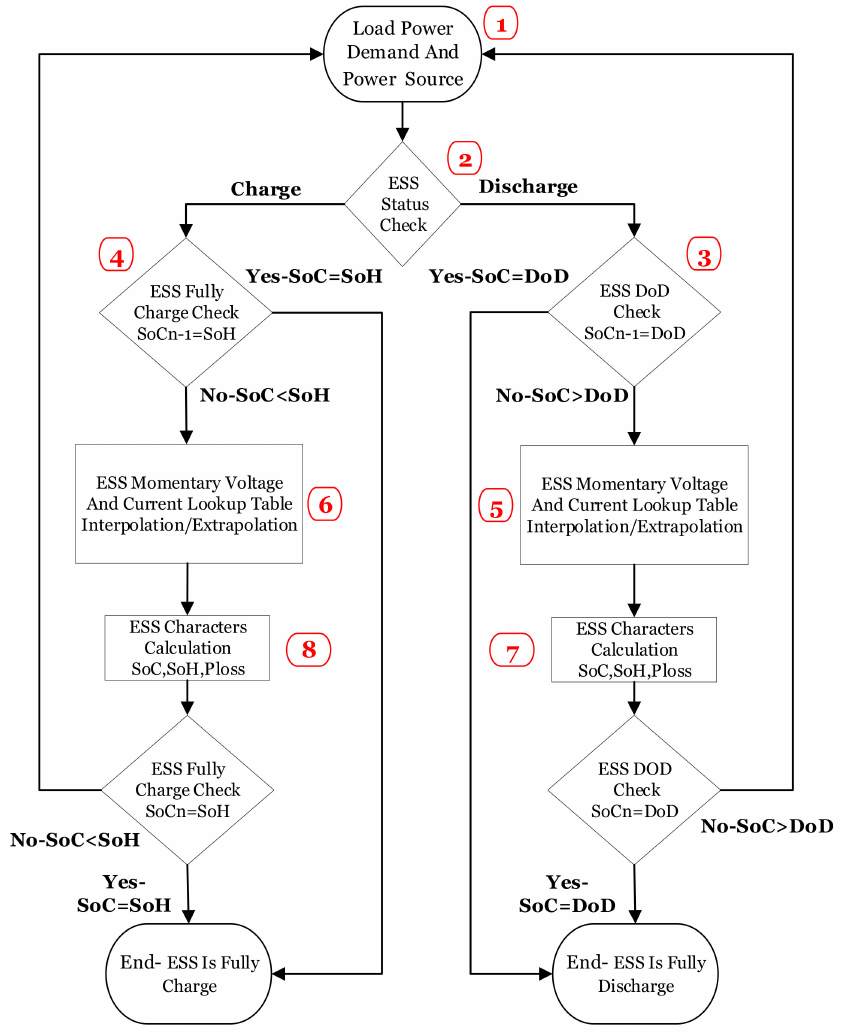
Figure 4. Generic ESS model